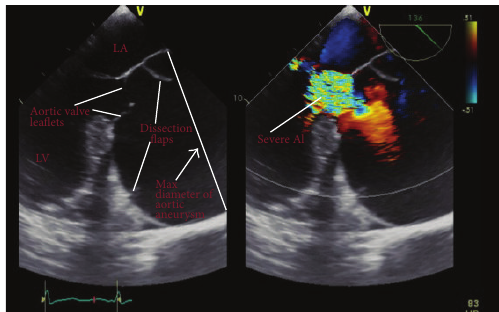
Figure 1: Transesophageal echocardiography in long axis aortic view showing giant aortic aneurysm (13cm) and incidentally found dissection flaps in the ascending aorta (left). Also seen is severe aortic regurgitation (right). LA: left atrium, LV: left ventricle, and AI: aortic insufficiency.